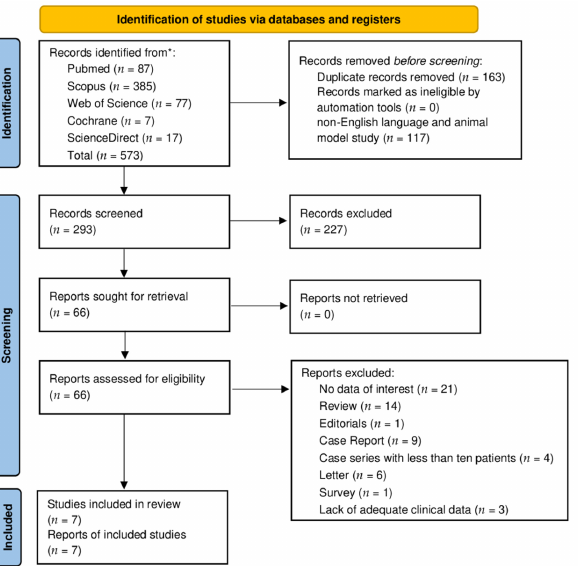
Figure 1. PRISMA [18] diagram resembling the electronic database search and inclusion/exclusion process of the review. Legend : * date of last search: 31 July 2022.